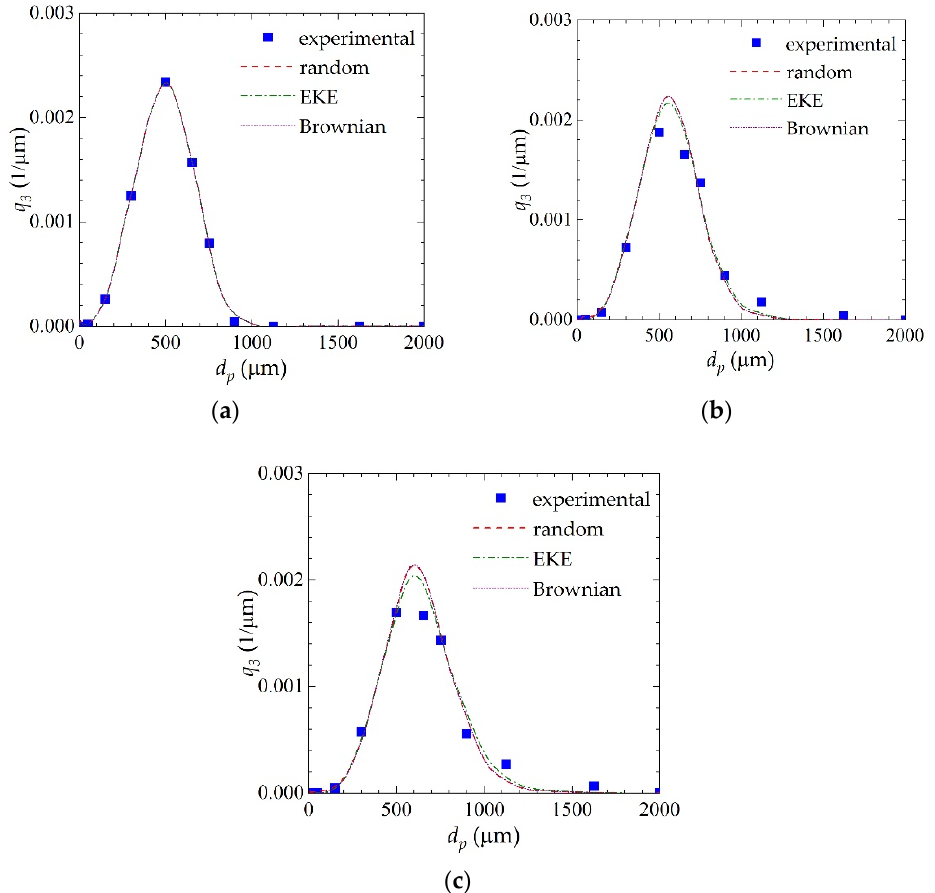
Figure 8. Measured and simulated mass density distribution q 3 for the test with tenside: ( a ) t = 0 min; ( b ) t = 10 min; ( c ) t = 20 min. Table 2. Aggregation rate constants β 0 obtained using different kernels.